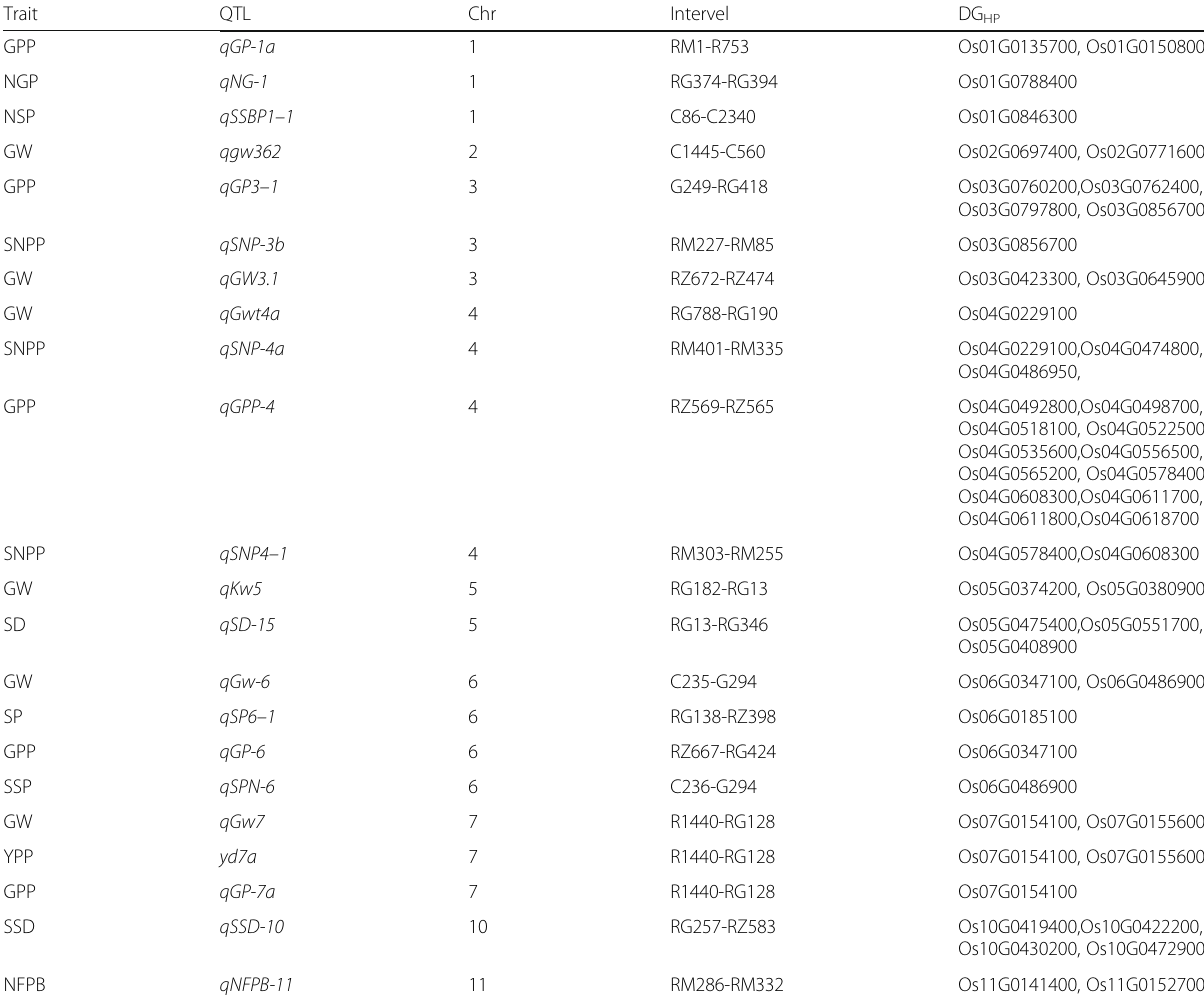
Table 6 Significant differentially Expressed Transcripts Mapped in each of the QTL Regions